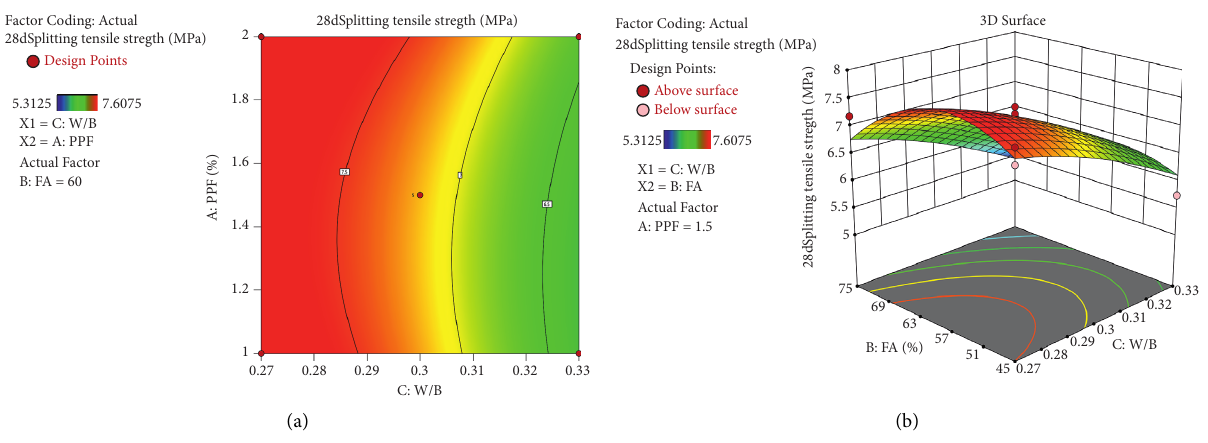
Figure 15: Contour plots. (a, b) 28 d splitting tensile strength